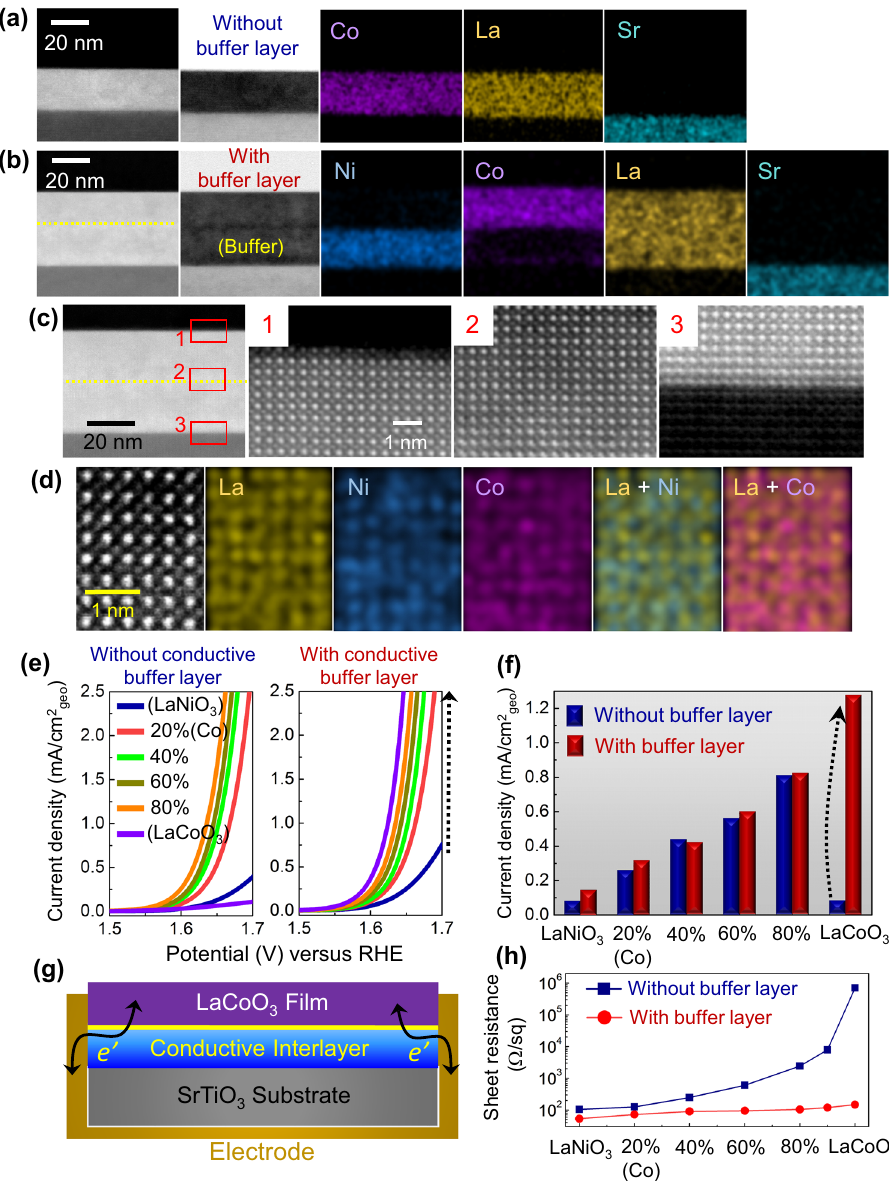
Fig. 5 La(Ni,Co)O 3 (001) solid-solution thin fi lms. Two different con fi gurations of thin- fi lm samples with and without a conductive interlayer